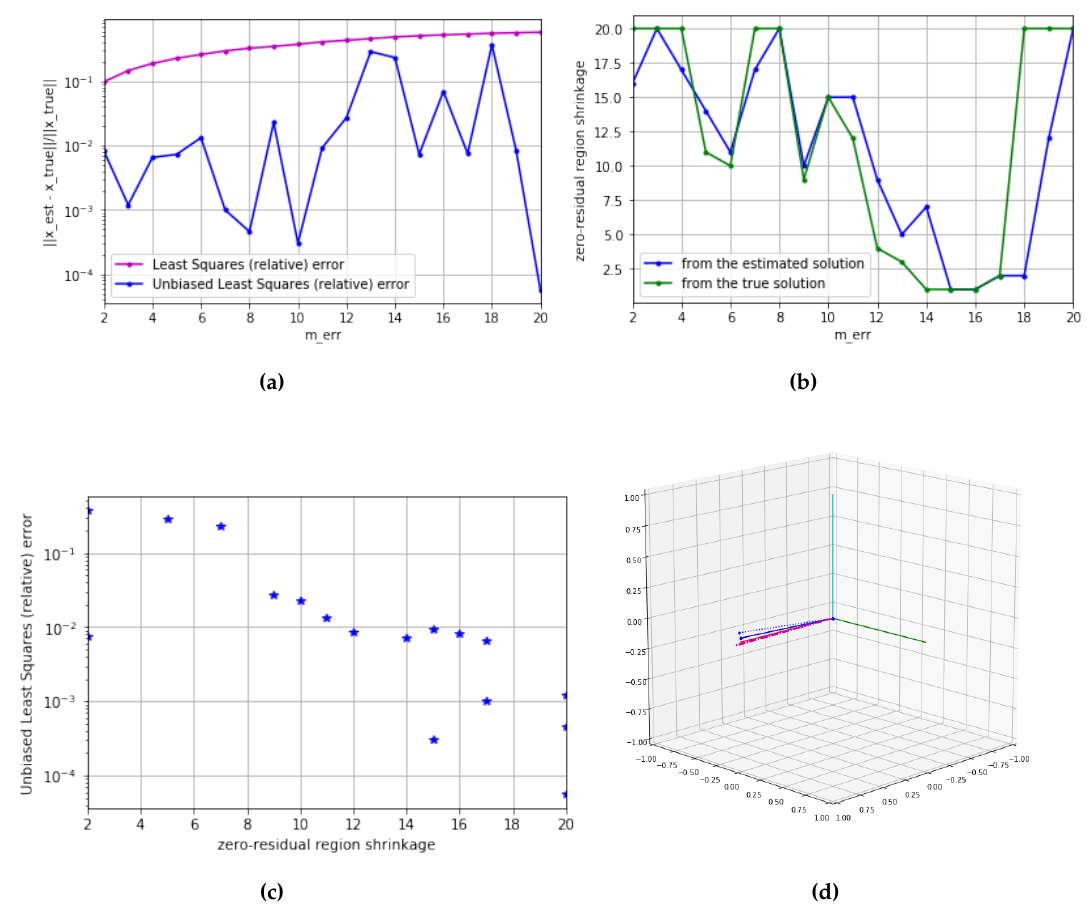
Figure 12. The plots summarize the results obtained by the ULS approach to parameter estimation no the model problem explained at the beginning of this section. ( a ): The relative estimation error (37) vs. m err ; ( b ): The I zr region shrinkage estimate (31) vs. m err ; ( c ): The relative estimation error (37) vs. the estimate of the I zr region shrinkage, considering the experiments with m err ∈ [ 2,20 ] ; ( d ): A three dimensional view of the Outgoing Gradients at the last iteration of the experiment with m err =